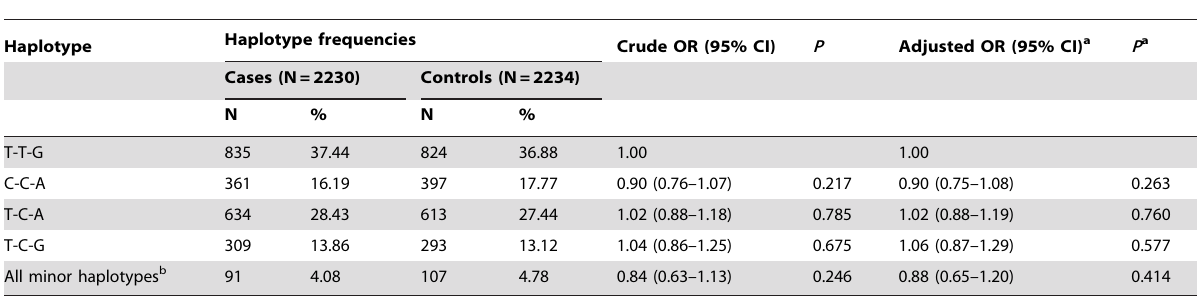
Table 4. Haplotype analysis for genotypes of ERCC5 and ESCC risk.